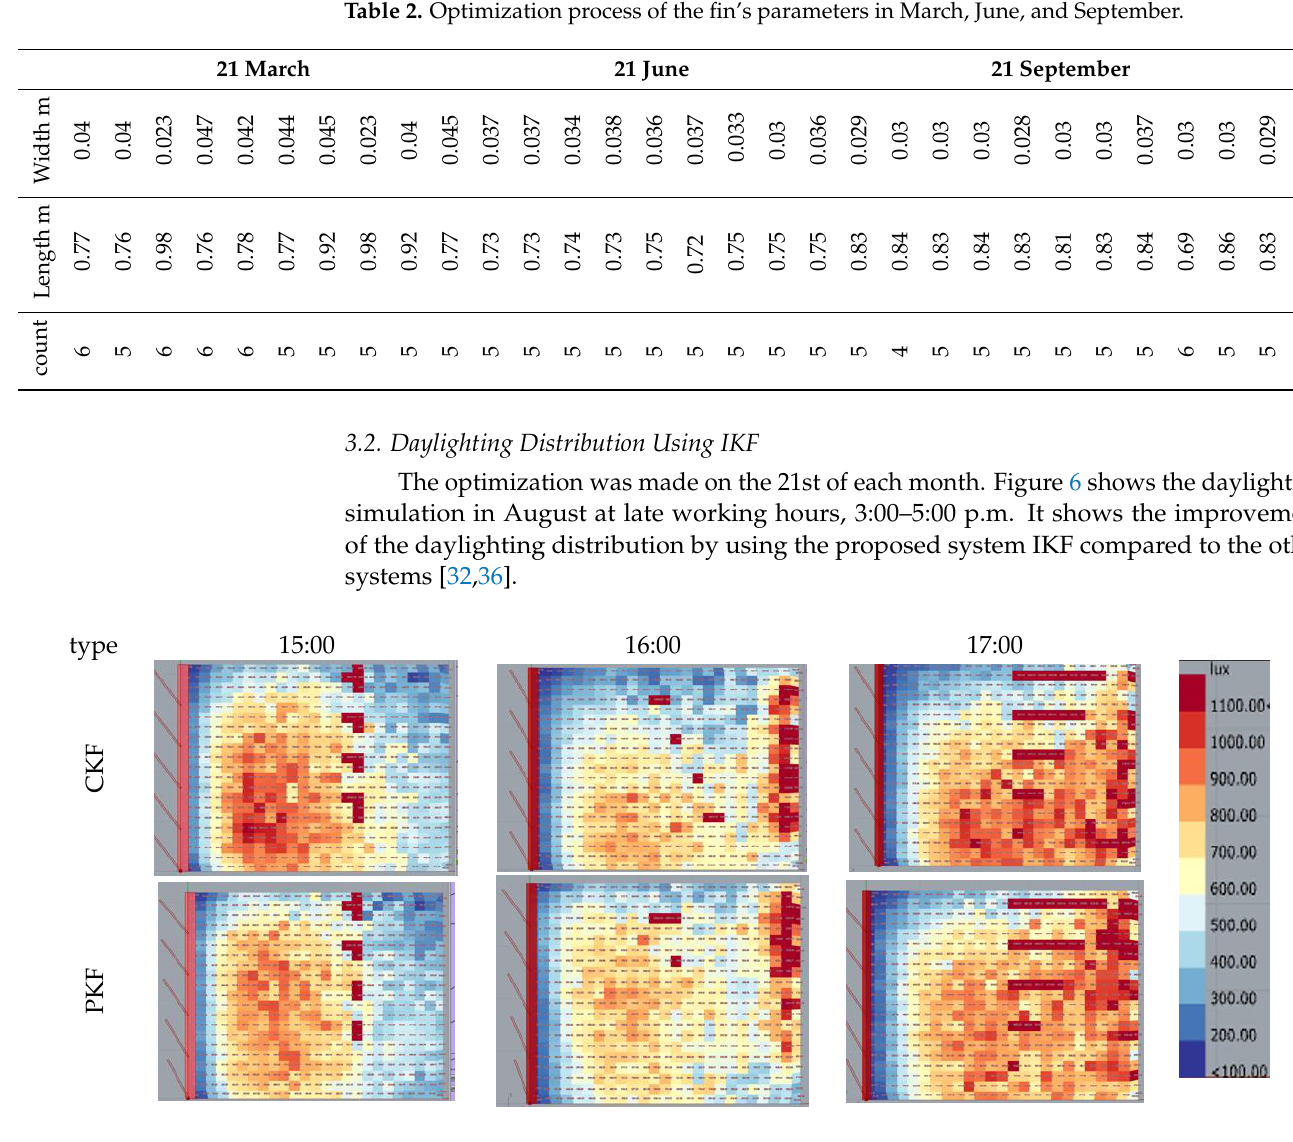
Table 2. Optimization process of the fin’s parameters in March, June, and September.